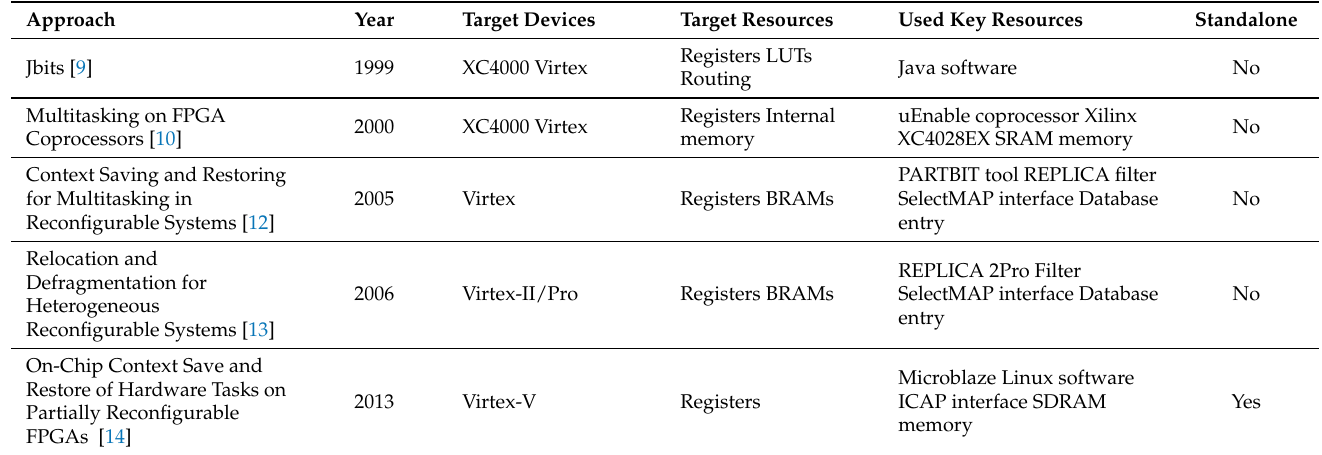
Table 1. Summary of the existing approaches that deal with user data content management through the bitstream for Xilinx